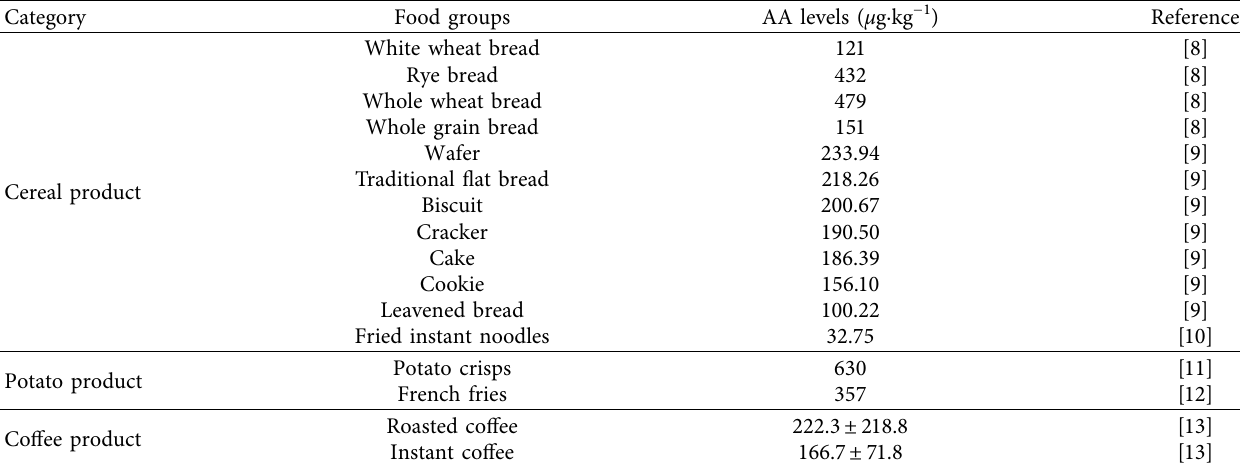
Figure 1: Major source of exposure to AA. Tere are four main routes of exposure to AA: dietary way, occupational exposure, cosmetics, and smoking. Table 1: Contents of AA in diferent food